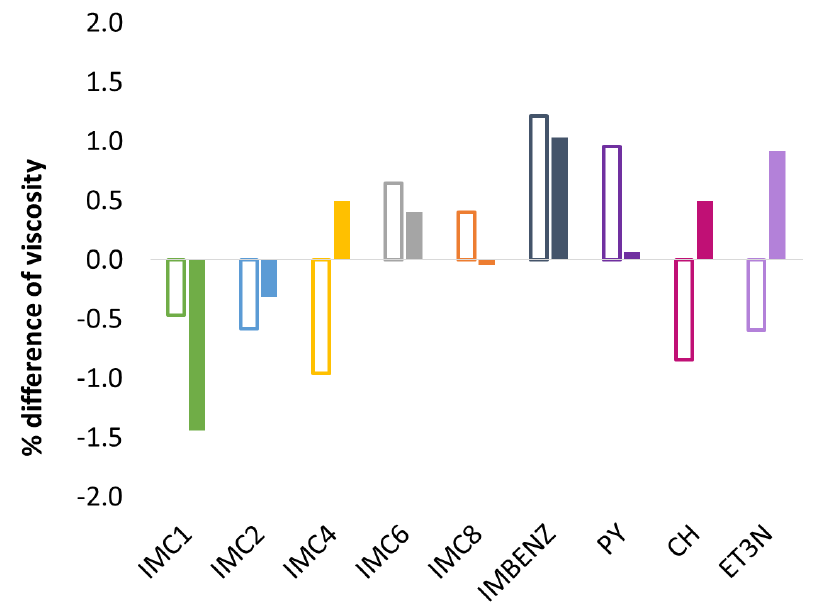
Figure 8. ∆ viscosity (in %) of GDILs in [C 2 mim][SCN] solution compared to the pure ionic liquid at 25 ◦ C. Open bars—open form GDIL (no irradiation) and full bars—closed form GDIL (upon UV irradiation, 240 min).